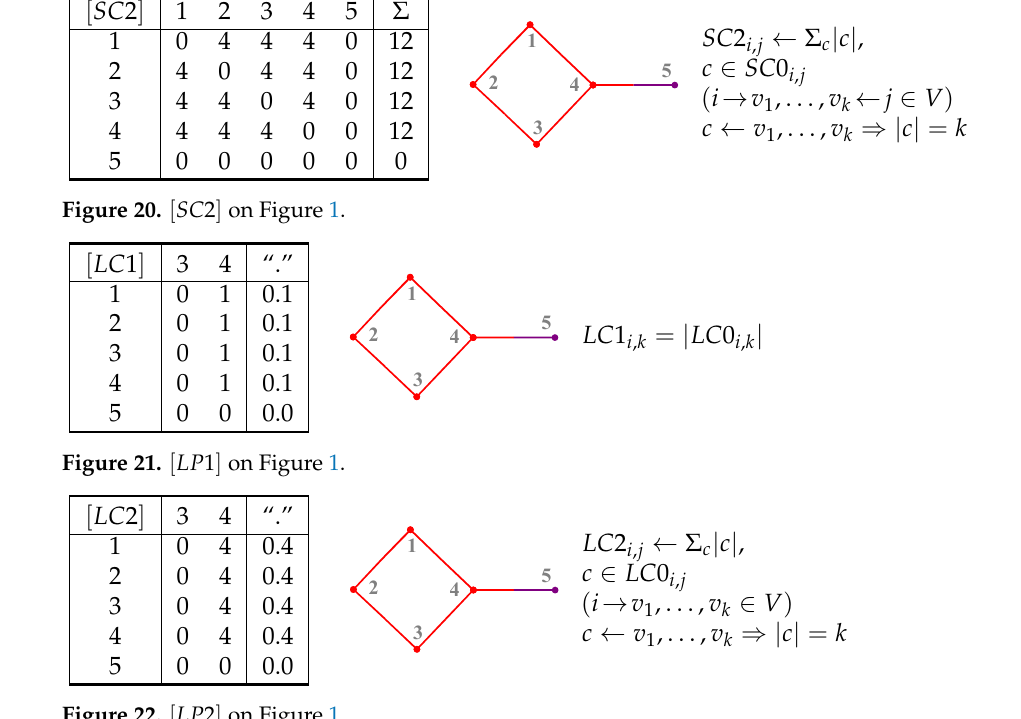
Figure 22. [ LP 2 ] on Figure